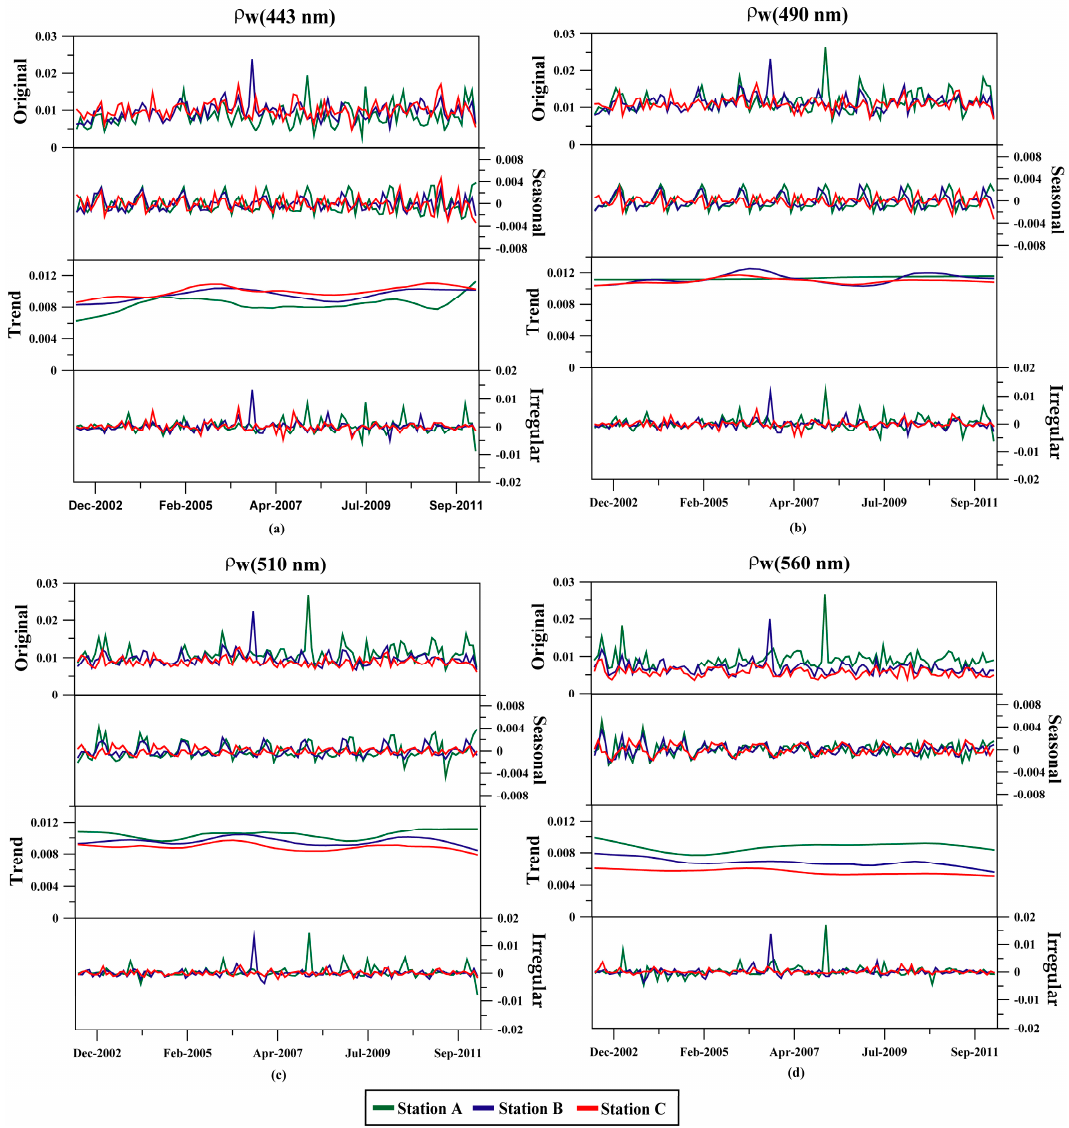
Figure 6. Decomposition plots of MERIS water leaving reflectance ( ρ w ) at: ( a ) 443; ( b ) 490; ( c ) 510; and ( d ) 560 nm, at the three Stations by stl.fit().